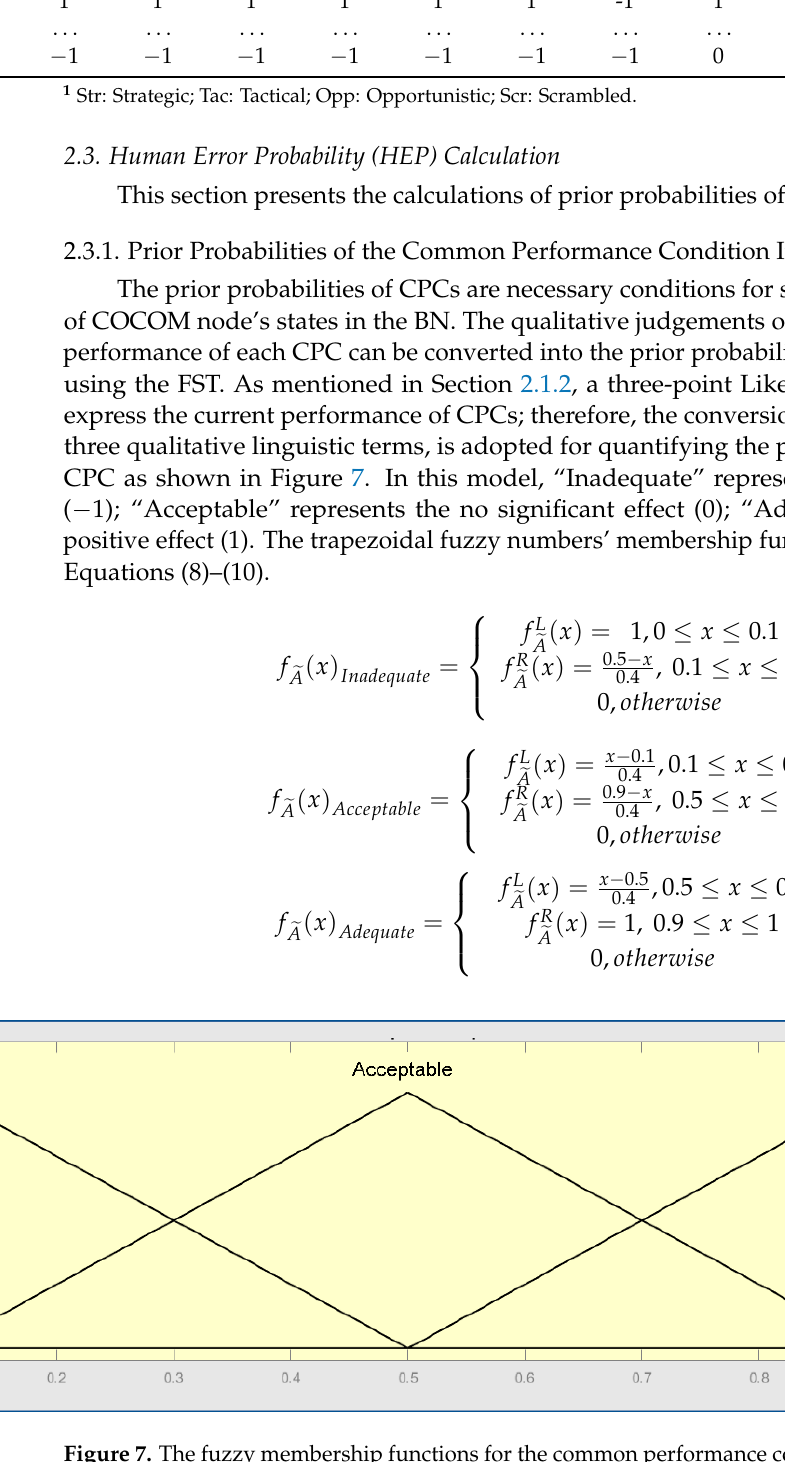
Figure 7. The fuzzy membership functions for the common performance condition indicators (CPCs).